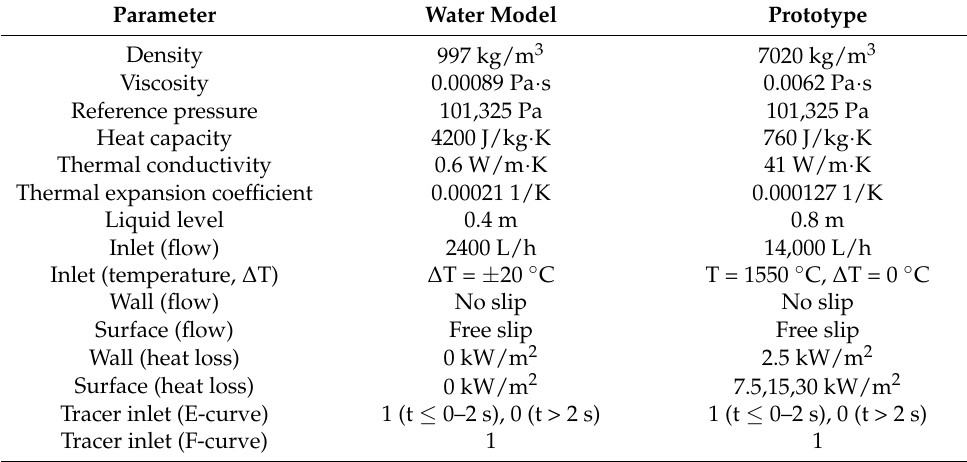
Table 2. Input parameters and boundary conditions used for computational fluid dynamics (CFD)